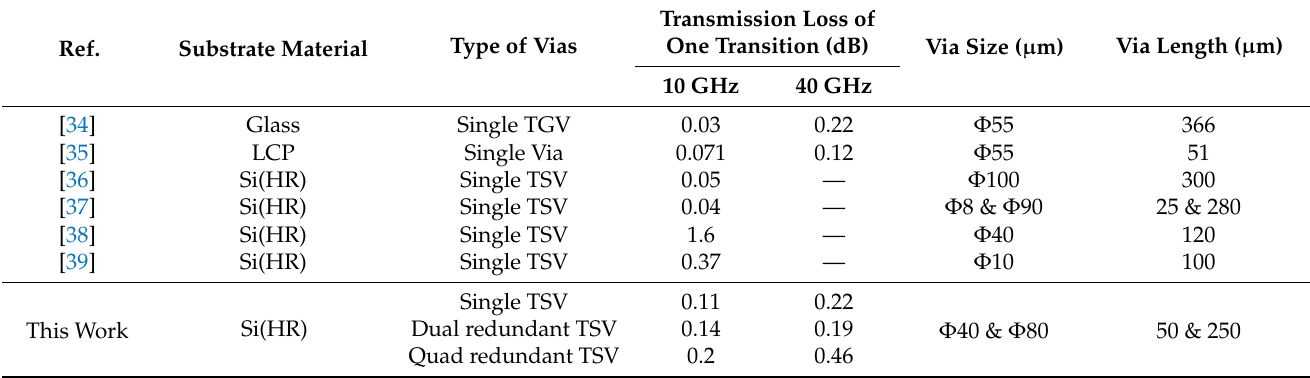
Table 4. Comparison RF TSV for high frequency